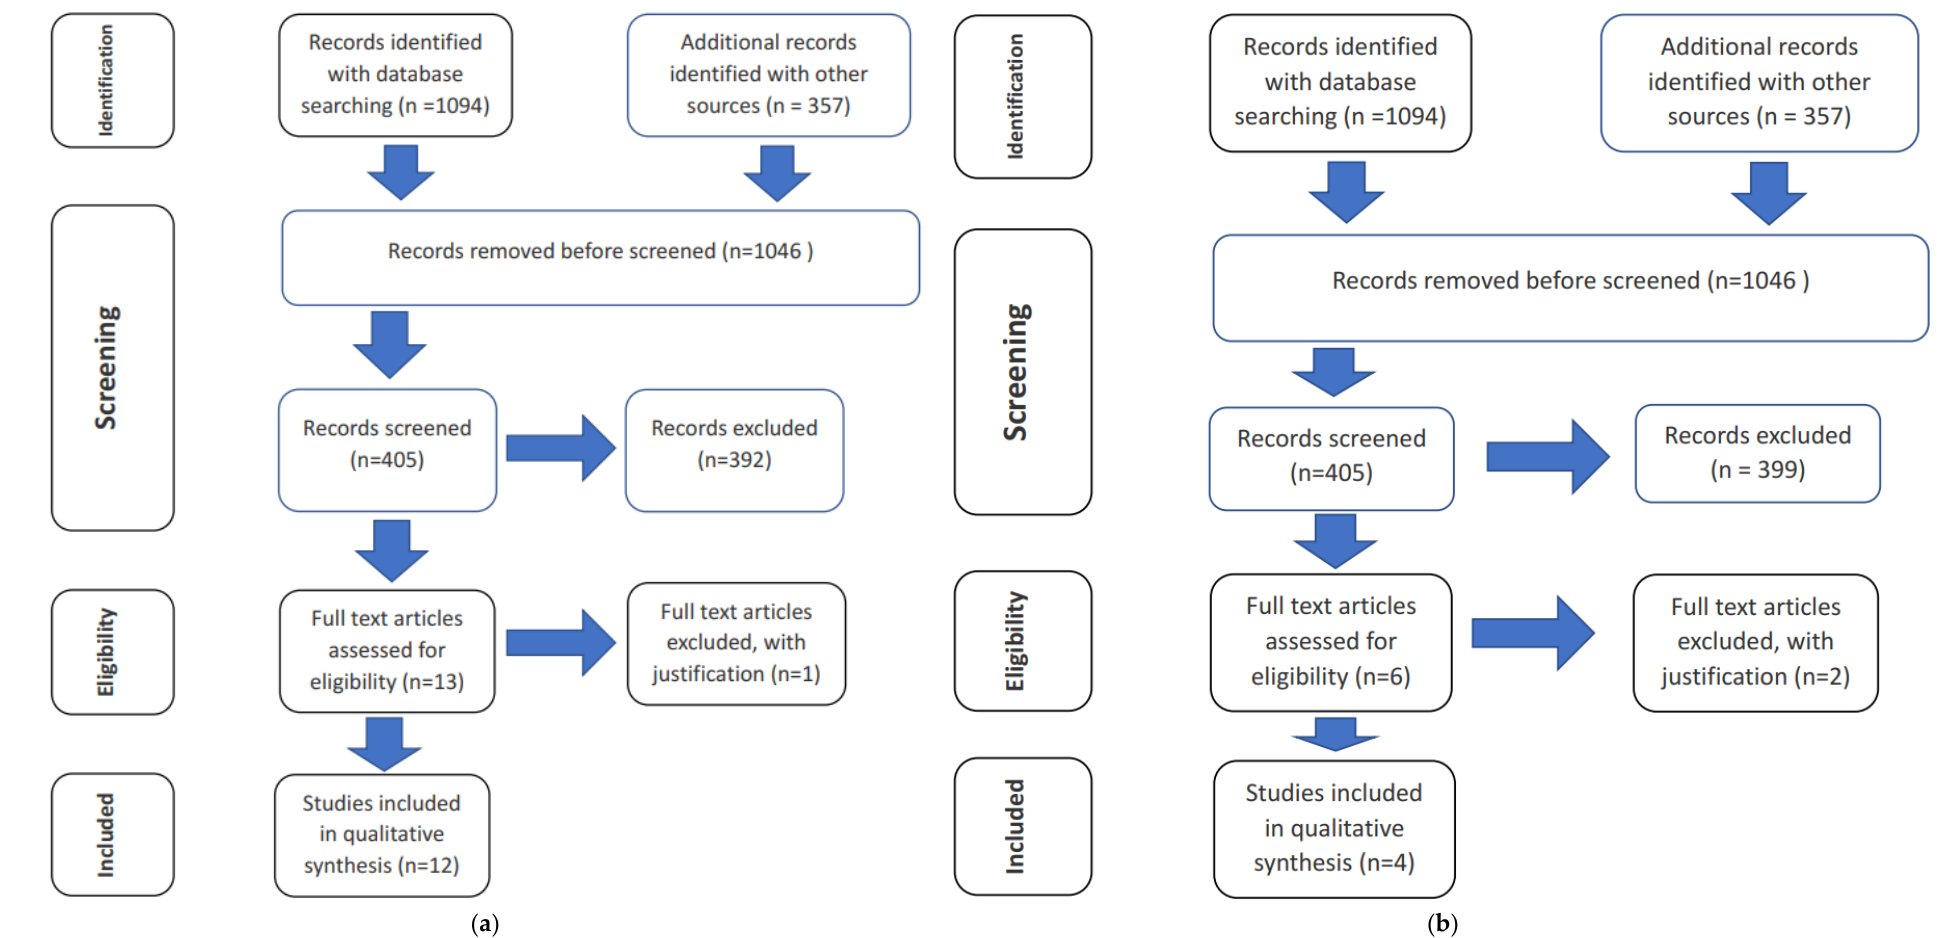
Figure 1. ( a ) The methodology used to select articles in relation to sagittal analysis. ( b ) The methodology used to select articles in relation to horizontal analysis [8].